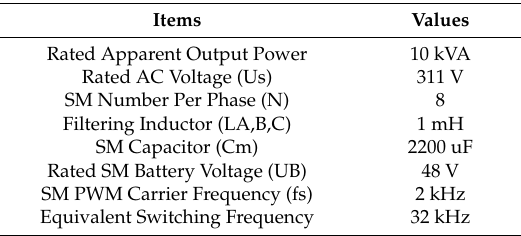
Table 4. Symbols and parameters of the prototype.